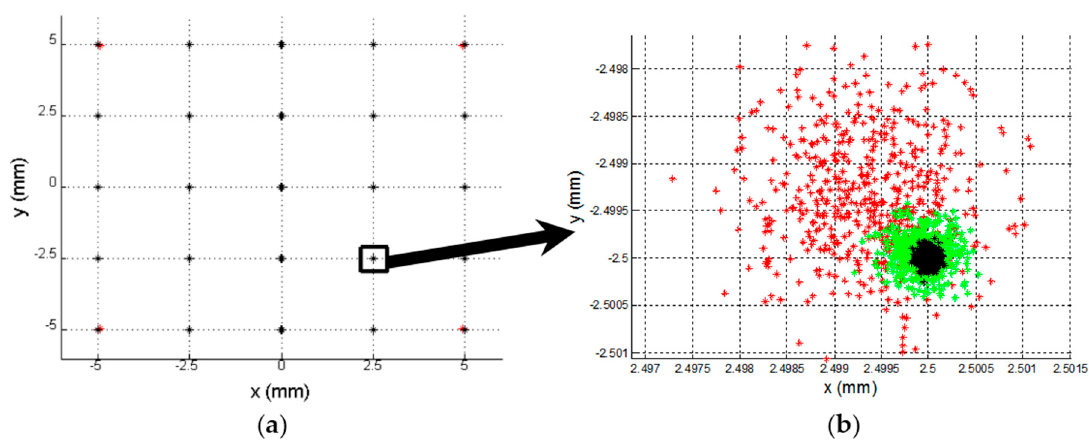
Figure 13. ( a ) SNR: 40 dB (red), 50 dB (green) and 60 dB (black) for 25 PSD sensor positions; ( b ) Enlarged. Table 2. Standard deviation, average and maximum and position errors (2.5, − 2.5).